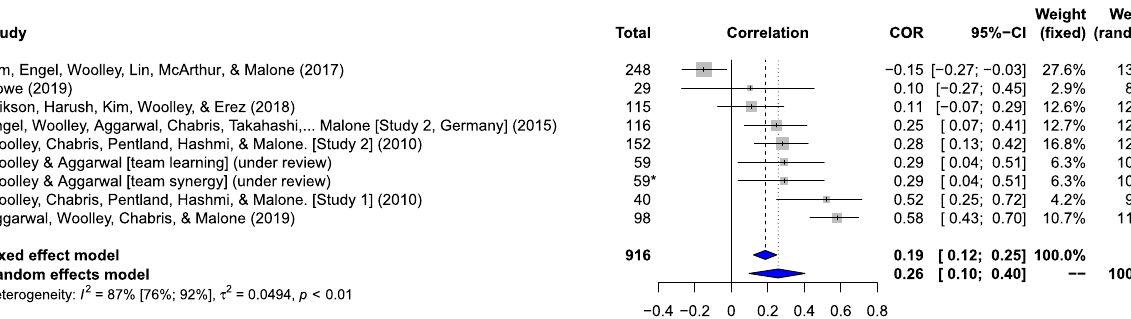
Fig. 3 Forest plot: The c- factor and Criterion Tasks. Note. Results are displayed for a random effects model pertaining to correlations between the c-factor and various criterion tasks. The c-factor scores are operationalized using factor/principal component regression weights. Most studies did not report which method was used to calculate these weights (e.g., Bartlett method). All studies included in this analysis, except for Rowe (2019), were undertaken by Woolley and colleagues and therefore employed procedures and measures described in Woolley et al. (2010) and/or Engel et al. ( 2014a b). Criterion tasks were different across all studies. Box sizes are relative to sample weights. *Two effects (team learning and team synergy) by Woolley and Aggarwal (under review) from one unique sample